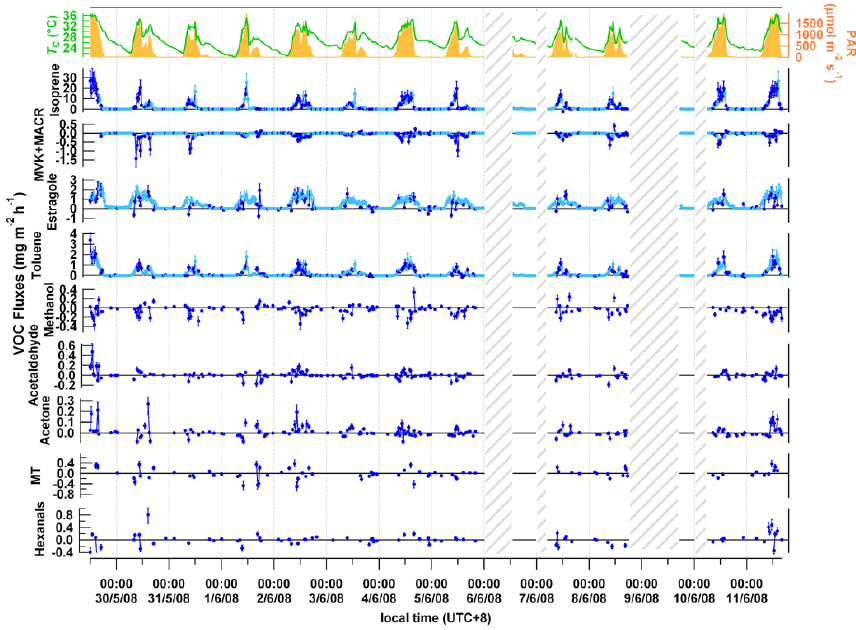
Fig. 4. Measured (dark blue) and modelled (light blue; see Sect. 3.5) flux time series of targeted VOCs. Crosshatched zones correspond to power